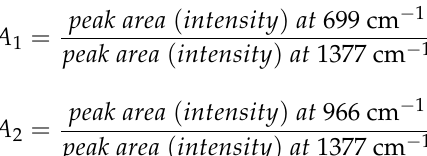
Figure 5 is the infrared spectrum of the modified asphalt with different SBS